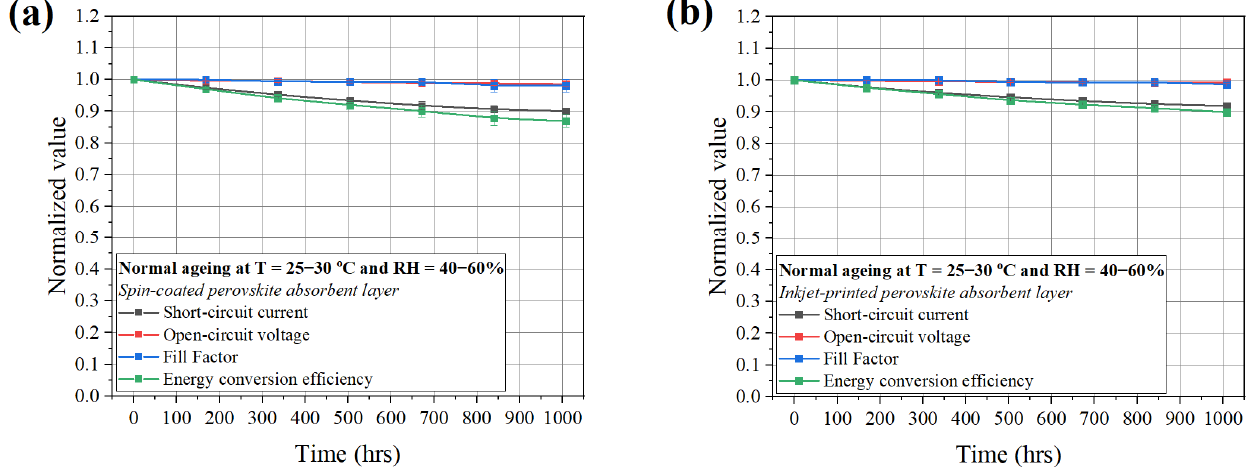
Figure 9. Normal ageing of the unencapsulated solar cells fabricated by the ( a ) spin-coated and ( b ) inkjet-printed perovskite absorbent layer.